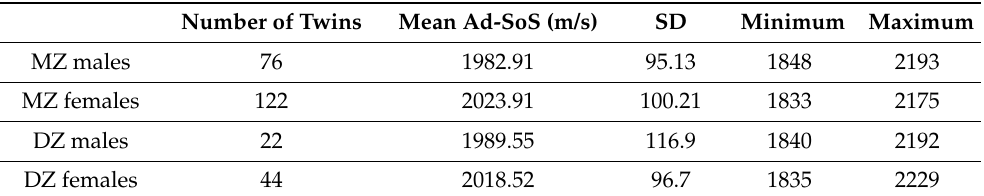
Table 2. Mean Ad-SoS for gender and zygosity classification. Number of Twins Mean Ad-SoS (m/s) SD Minimum Maximum